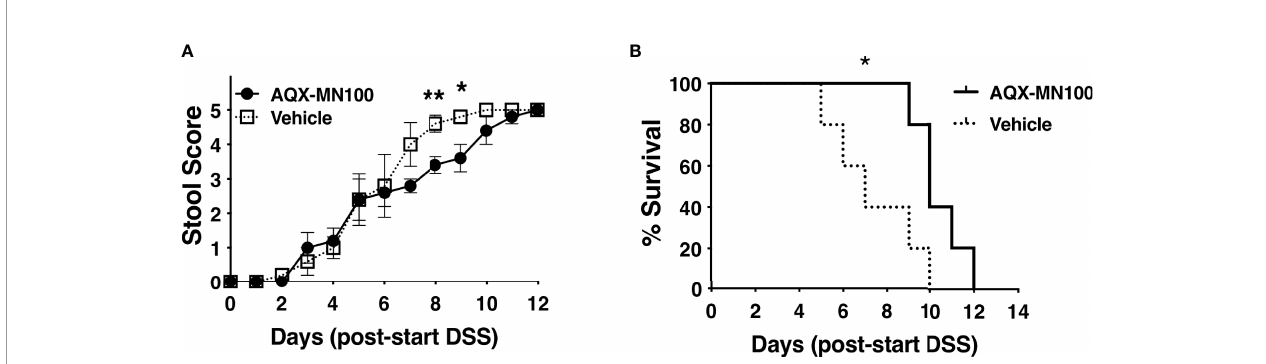
FIGURE 5 | SHIP1 agonism extends survival of LRBA-de fi cient mice in a lethal DSS-colitis model. Mice were placed on DSS-containing drinking water for 7 days and dosed with AQX-MN100 (3 mg/kg) or vehicle (n = 5/group) via daily oral gavage (10 ml/g) for 8 days beginning 1 day prior to exposure to DSS-containing drinking water. (A) Stool score was monitored daily and ranked at 5 when a mouse was euthanized based on rectal bleeding and weight loss (two-tailed Student ’ s t- test was used to compare mice on each day, **p < 0.01, *p < 0.05). (B) Survival of the two cohorts was compared by the Kaplan – Meier log-rank test (*p < 0.05). DSS, dextran sulfate sodium.